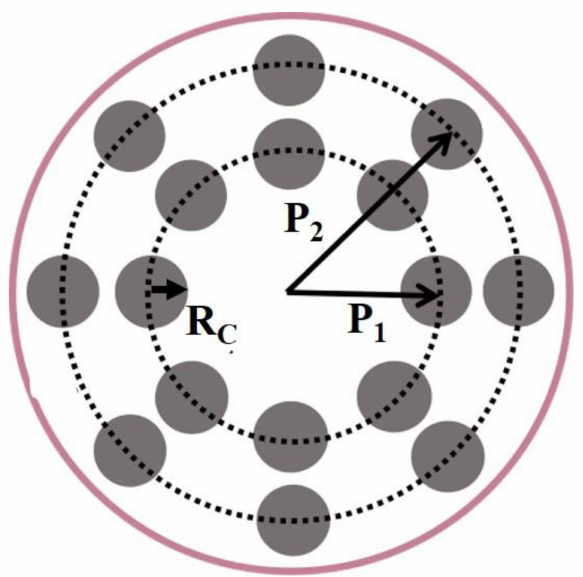
Figure 7. Schematic of spot array light irradiation. P 1 and P 2 are the positions of the inner spot and outer spot. In our calculations, the numbers of the inner spot light and the outer spot light are both eight, and the radius of the spot, R C is equal to 0.15 mm.